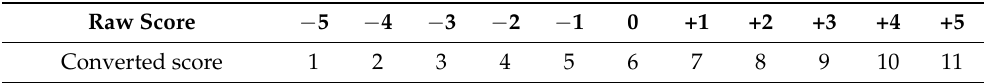
Table 2. Q-Sample classification and score